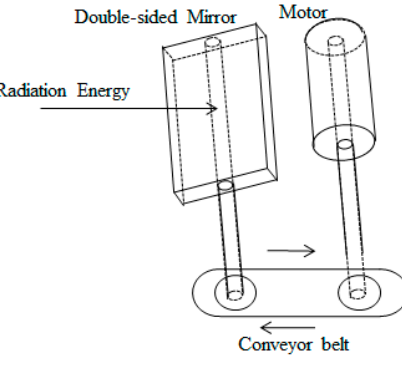
Figure 4. A structural schematic diagram of the rotating mirror.